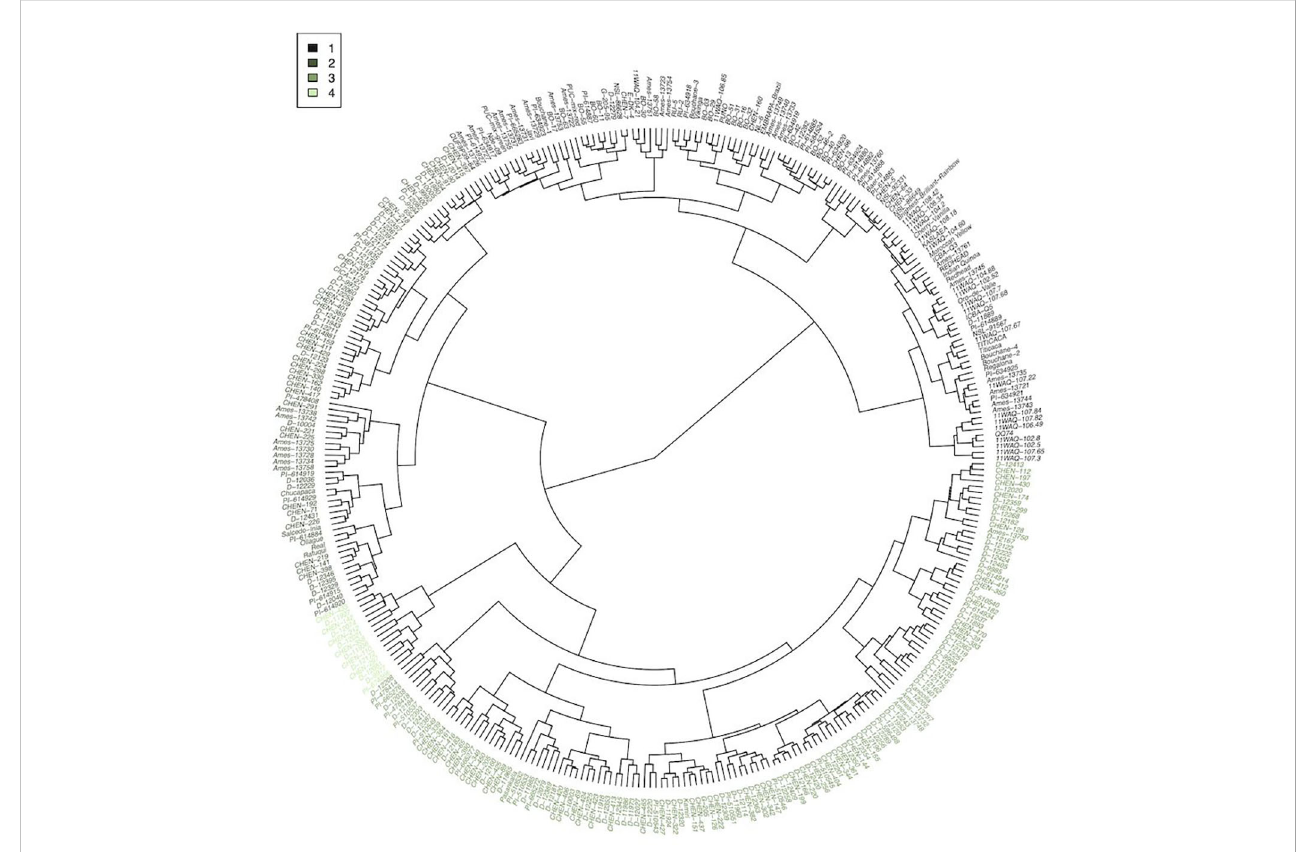
FIGURE 3 Agglomerative cluster analysis, calculated fi rst with a Euclidean distance matrix and then Ward ’ s method for clustering, of accession best linear unbiased estimates using a subset of the phenotypic traits (days to anthesis, fruit set/ripening, days to harvest, height at 5 weeks and 6 weeks after sowing, height at harvest, in fl orescence length, width and area, ash, crude fat, crude protein, total amino acids, yield per plant, TSW, seed area, eccentricity, and total RGB). The dendrogram was cut to form 4 groups, and each cluster ( N = 4) is color coded according to the legend. Cluster identities are also provided in Supplementary Table S4 under column ATC (i.e. all trait